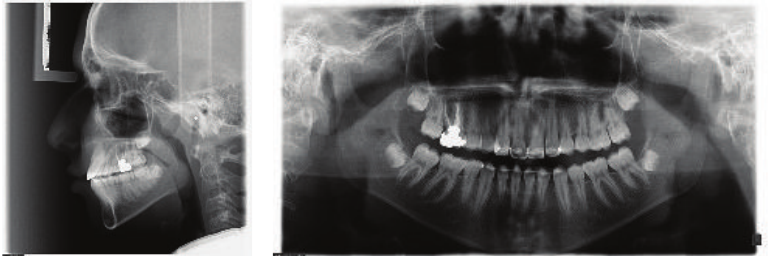
Figure 7: Posttreatment lateral cephalometry and panoramic